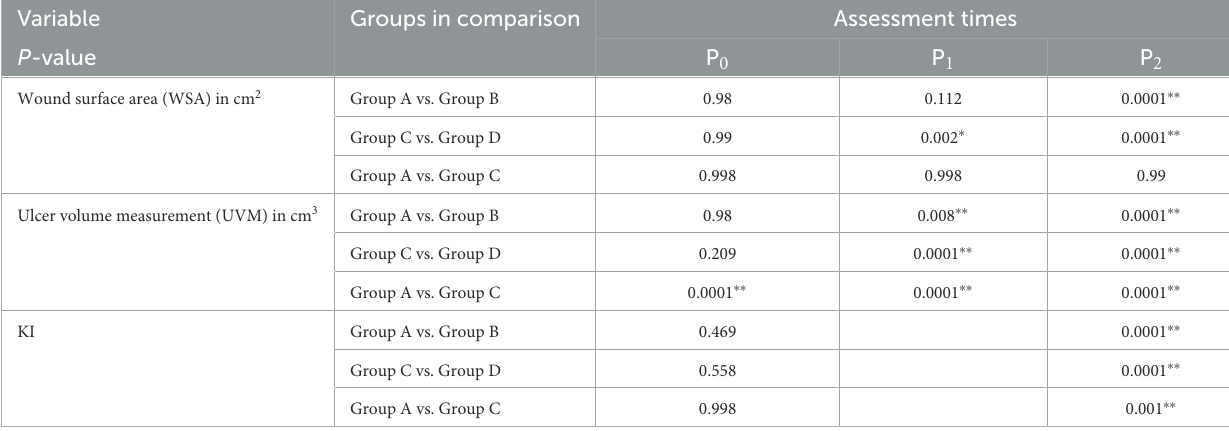
TABLE 4 Multiple pairwise comparisons for outcomes between both tested groups. Variable Groups in